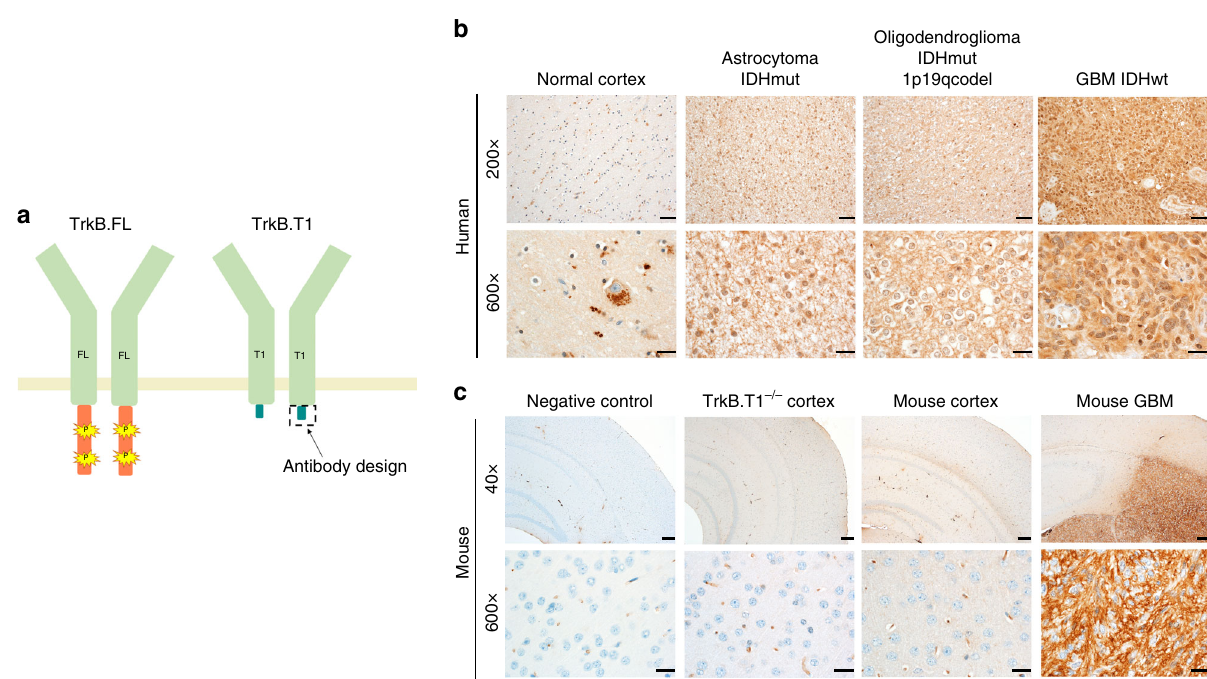
Fig. 4 Human and rodent TrkB.T1 immunostaining in normal brain and glioma. a Receptor schematic of TrkB.FL (kinase domain demonstrated in orange with phosphorylation sites in yellow) and TrkB.T1 highlighting region of antibody speci fi city (11-amino acid region shown in teal blue). Extracellular domain, transmembrane domain, and fi rst intracellular amino acids common to both variants shown in light green. TrkB.T1 immunohistochemistry shows punctate vesicular staining in normal human ( b ) and mouse cortex ( c ) compared with intense diffuse staining in human glioma ( b ) and mouse glioma ( c ) with lack of punctate vesicular pattern. Lack of staining in rodent negative control (no primary antibody) and TrkB.T1 − / − cortex demonstrates antibody speci fi city for TrkB.T1 splice variant. (IDHmut — IDH mutant; 1p19q codel — 1p 19 q co-deleted). Immunohistochemistry was performed on independent biological samples of each tumor type, in replicates of 3 – 5. Representative images were chosen and additional images are shown in Supplementary Fig. 4 – 6. Photomicrographs are as speci fi ed at 40×(scale bar = 200 µ m), 200×(scale bar = 50 µ m), and 600×(scale bar = 20 µ